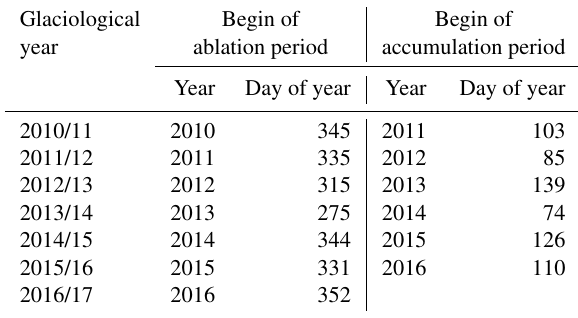
Table 2. Definition of beginning and end of the glaciological sum- mer deducted from observations of local minima and maxima of the accumulation/ablation time series at the mass balance transects (PG0 x and PG1 x ) on Potter Peninsula, King George Island, during the time period November 2010 to December 2016. Glaciological Begin of Begin of year ablation period accumulation